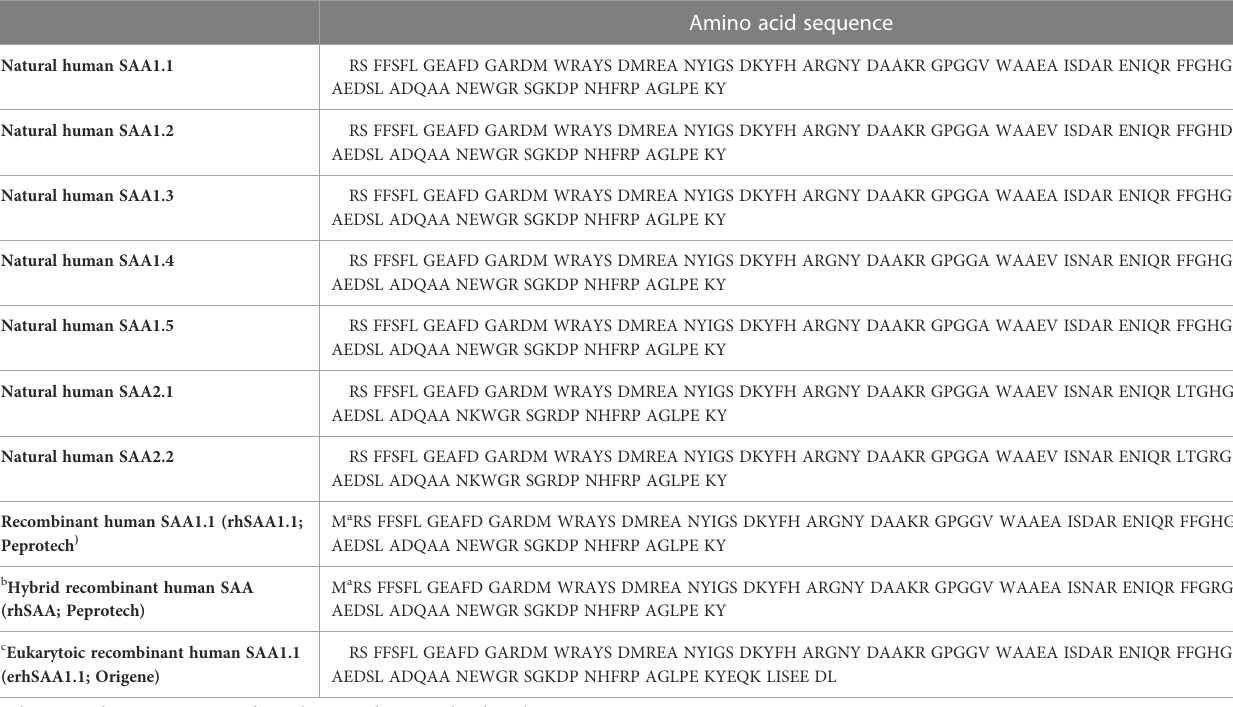
TABLE 1 Amino acid sequence of naturally occurring and commercially available recombinant human A-SAA preparations discussed in the present